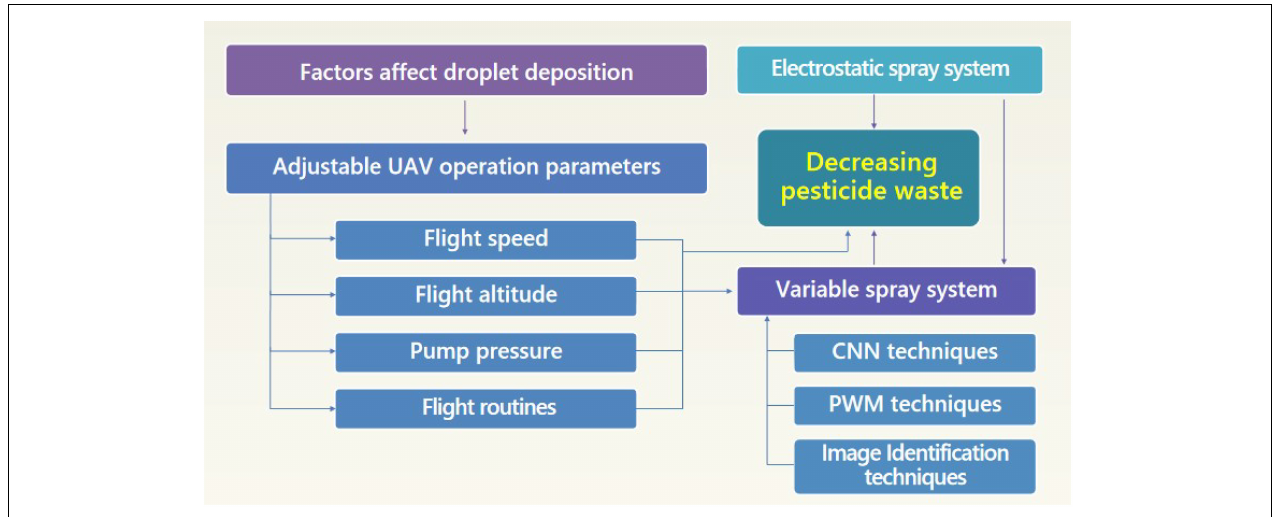
FIGURE 2 | The relationship network of various methods and their reduction in pesticide waste.